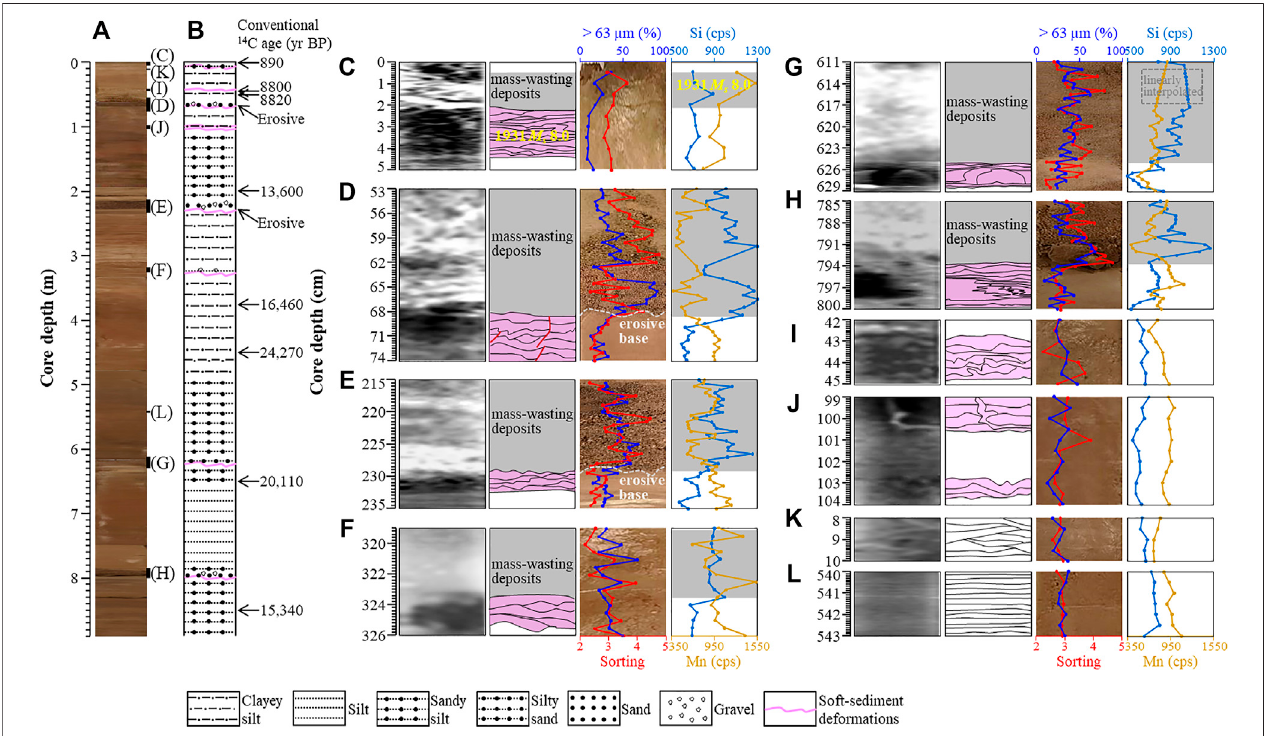
FIGURE2|(A) Opticalimageand (B) lithologyandconventional 14 CagesoftheY20Bcore. (C – H) Soft-sedimentdeformationstructures(SSDS)fromradiographic imagesoftheY20Bcore,withoverlyingsandydeposits(mass-wastingdeposits). (C,E,F) Linearwaves. (D) Micro-faults. (G) Convolutestructures. (H) Linearwavesand clastic dykes. The mass-wasting deposits are generally characterized by high sand percentages, sorting indices and Si contents, and relatively low Mn contents. Note thatthesedimentary structures arenotclearinopticalimages, potentially due tothelowsedimentationrates.Sharperosivebasescanbefoundat theinterfacesof typical mass-wasting deposits and the underlying SSDS in (D,E) . The mass-wasting deposits overlyingthe SSDS in (C) are related to the 11 August 1931 M s 8.0 Fuyun earthquake. (I,J) Isolated SSDS without overlying mass-wasting deposits. (I) Linear waves. (J) A clastic dyke (upper) and linear waves (lower). (K) Cross bedding. (L) Horizontal laminations (background sediments). Cps, counts per second. High sorting indices indicate poor sorting of sediments.